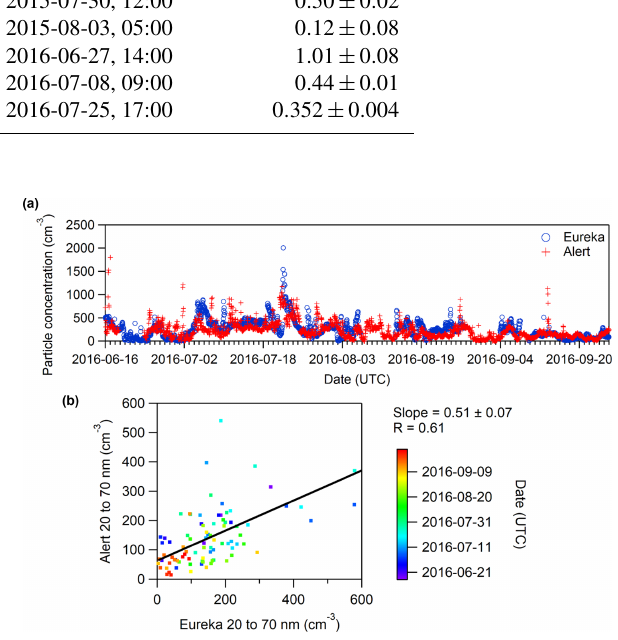
Figure 2. Total hourly particle number concentrations measured at the PEARL RidgeLab near Eureka and in Alert during summer 2016 for sizes between 10 and 487nm (a) . Scatter plot showing the correlation of the particle number concentrations measured in Alert and near Eureka (b) . Note that the data in the scatter plot correspond to daily averages of particles with diameters between 20 and